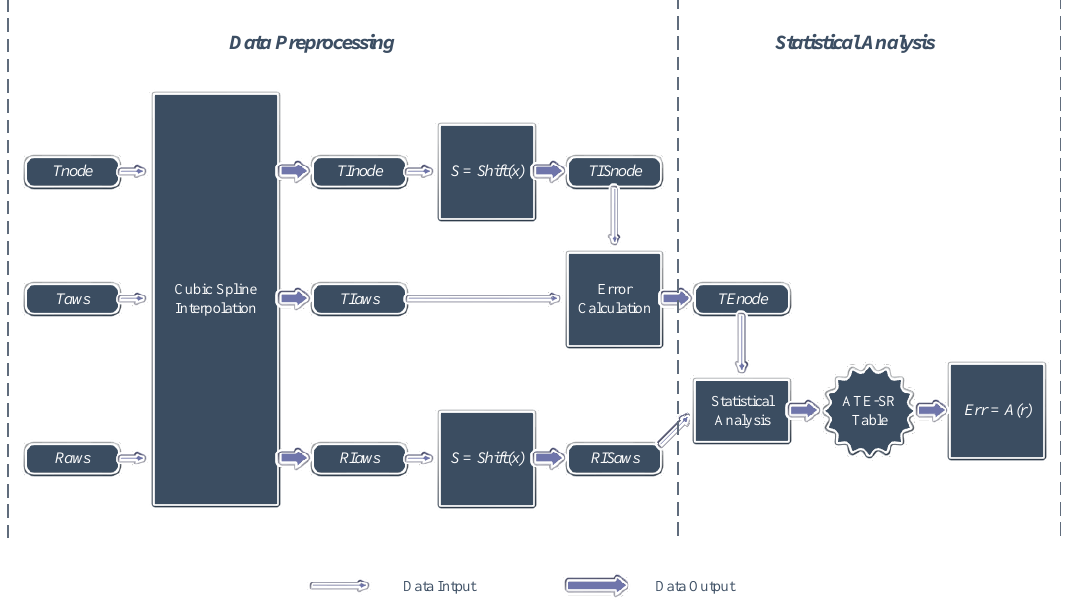
Figure 2. The procedure of data preprocessing and analysis.